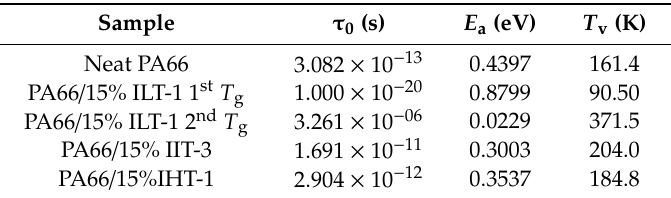
Table 3. Fit parameters of the VFTH equation.